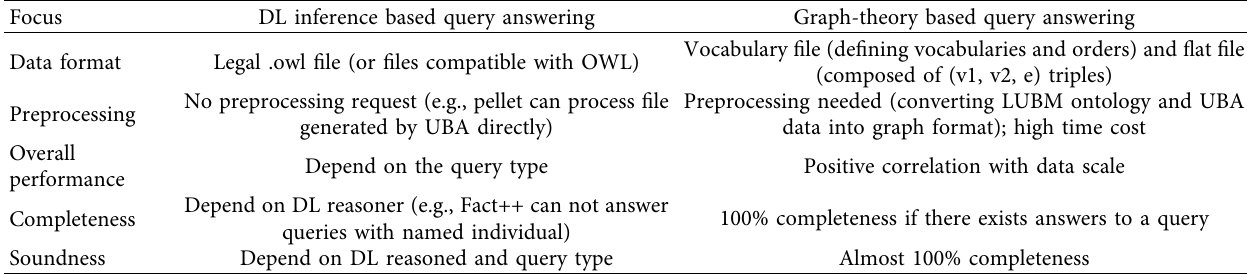
Table 6: Comparison of two different reasoning